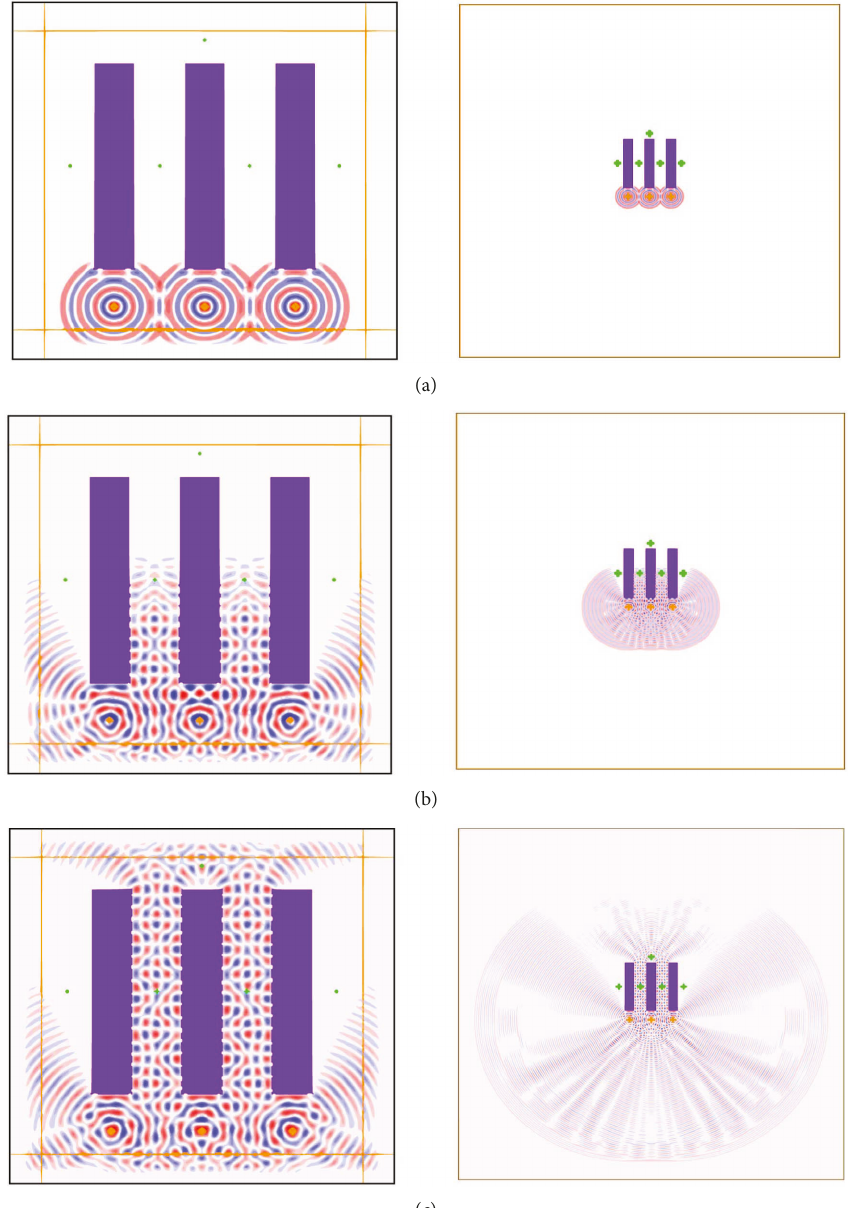
Figure 14: Distribution of electric fi eld ( E z ) in the CNWG for a propagation frequency of 100 THz. Cases (a), (b), and (c) represent snapshots of the propagation at n = 100 , 350, and 1160 time steps.